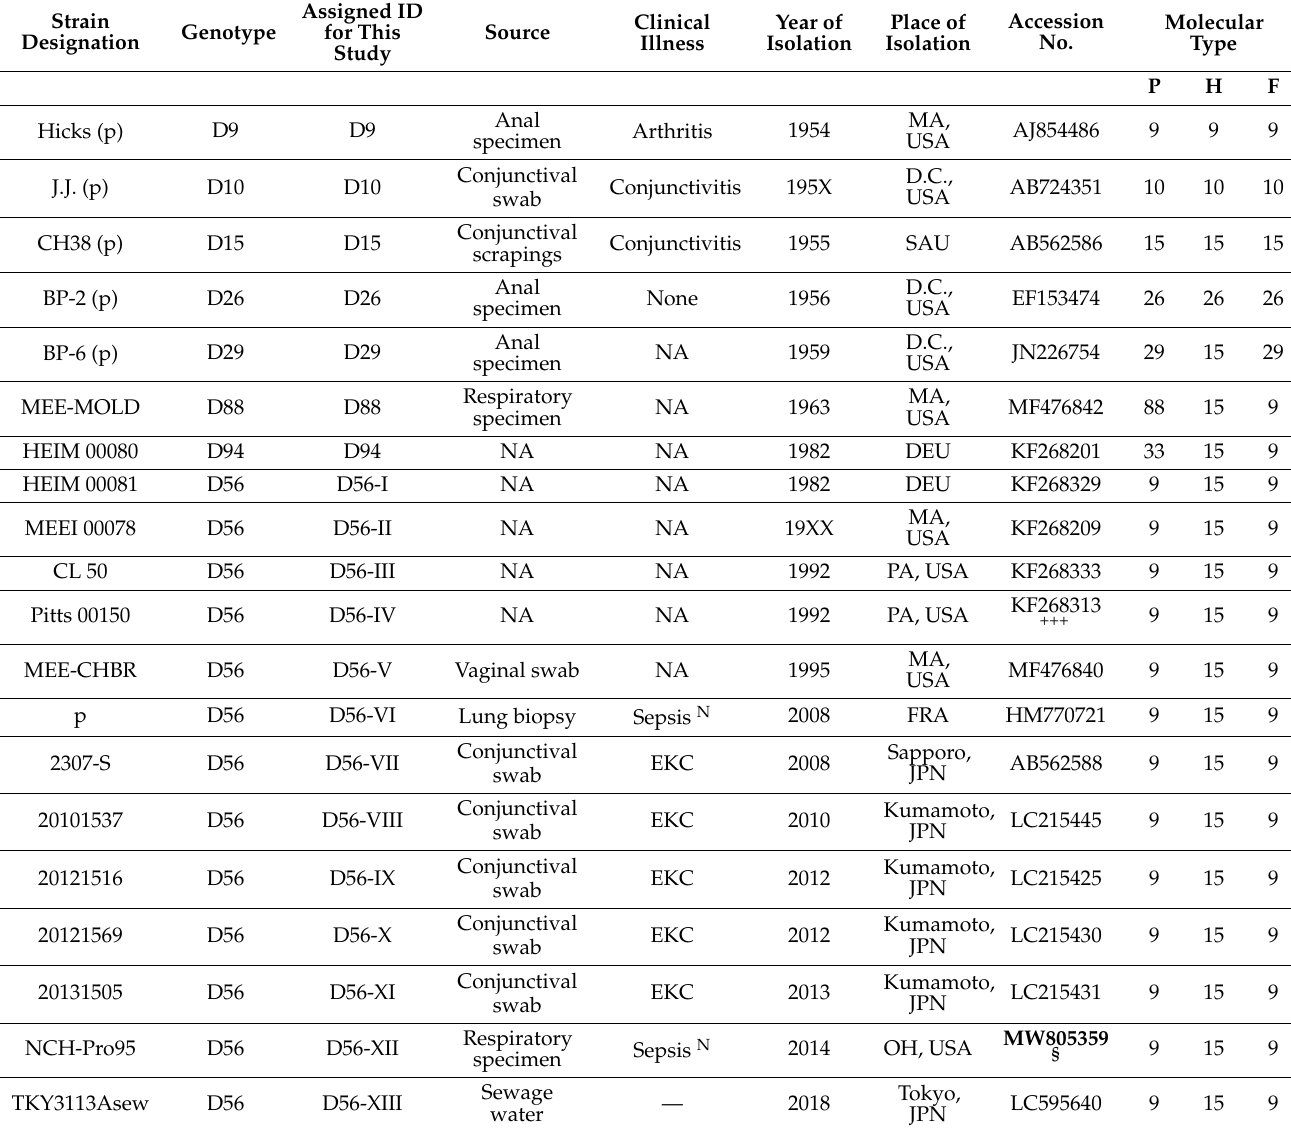
Table 1. Human mastadenovirus D genotypes and strains included in the genomic